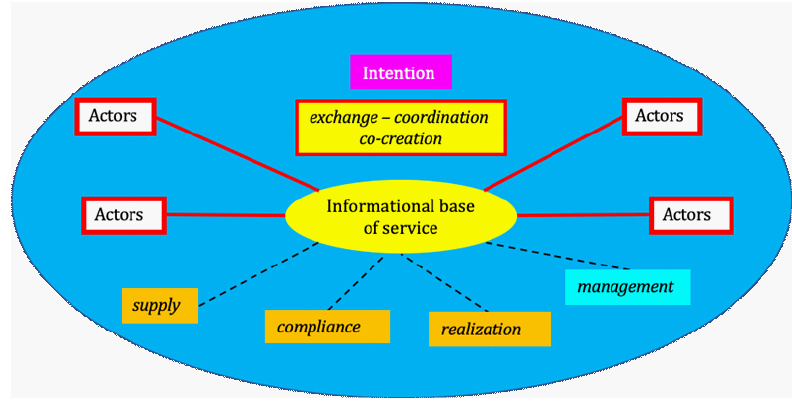
Figure 2. Service in the Responsible Service logic